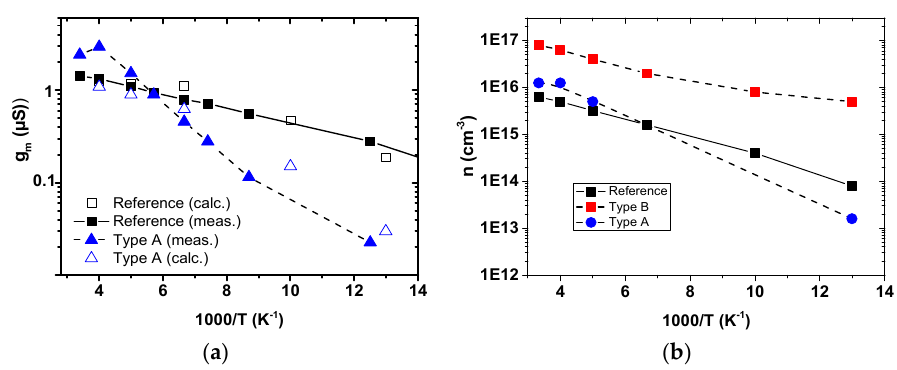
Figure 9. Measured (full symbols) and calculated temperature-dependent transconductance g m (open symbols) of devices without (reference, squares) and with dislocations (type A, triangles) in the channel of a nMOSFET ( a ). Computed electron density n vs. reciprocal temperature for devices without and with dislocations ( b ).